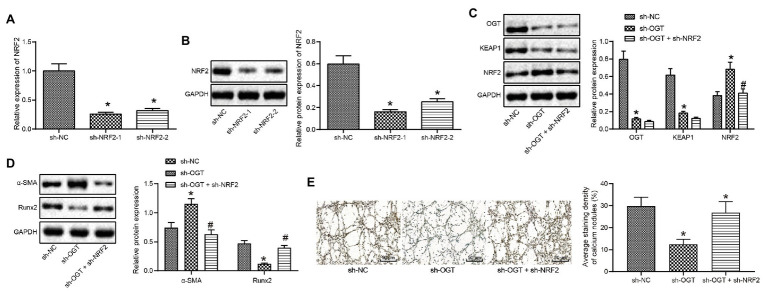
OGT silencing restricts calcification of VSMCs through inhibiting KEAP1-induced NRF2 degradation. (A) RT-qPCR detection of silencing efficiency of shRNAs targeting NRF2 in VSMCs. (B) Western blot assay of silencing efficiency of shRNAs targeting NRF2 normalized to GAPDH in VSMCs. (C) Western blot assay of protein levels of OGT, KEAP1, and NRF2 normalized to GAPDH in response to OGT knockdown and NRF2 knockdown. (D) Western blot analysis of expression patterns of calcification-related proteins Runx2 and α-SMA normalized to GAPDH in response to OGT knockdown and NRF2 knockdown. (E) Von Kossa staining and quantitative analysis showing calcium deposition in VSMCs in response to OGT knockdown and NRF2 knockdown. *p < 0.05 vs. cells transduced with sh-NC. #p < 0.05 vs. cells transduced with sh-OGT (in vitro experiments were repeated three times independently).